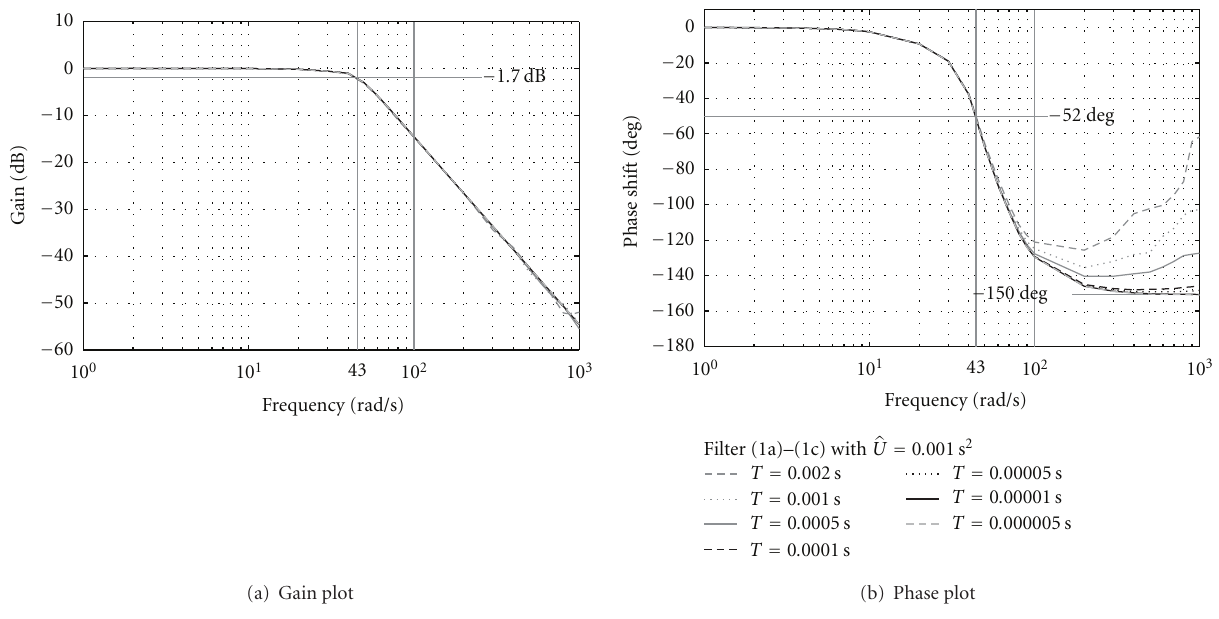
Figure 7: Bode plots for di ff erent values of sampling interval T